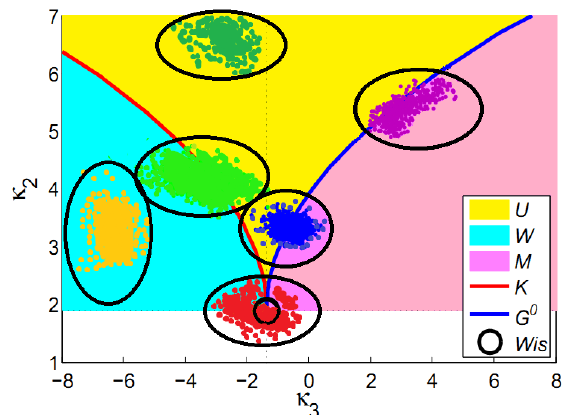
Figure 10. Comparison between kappa and accuracy